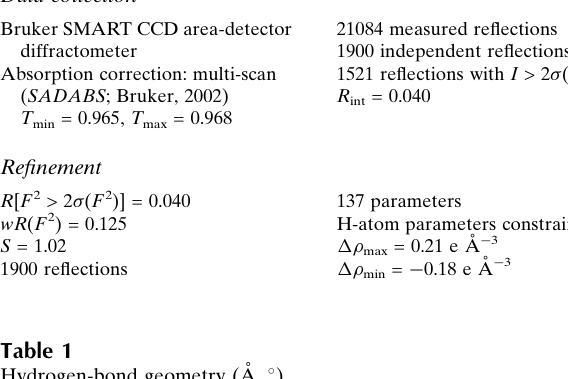
Hydrogen-bond geometry (A˚ , (cid:1) ). Cg 1 is the centroid of the C1–C6